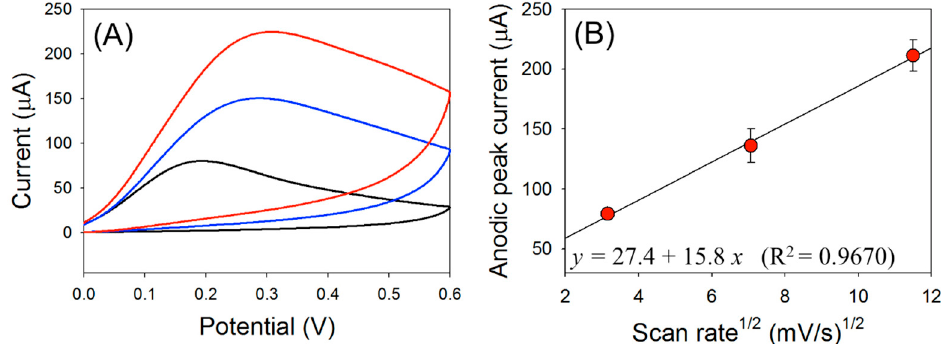
Figure 4. ( A ) Cyclic voltammograms of 10 mM·HZ in Tris buffer with pDA-ITO electrodes at a scan rate of 10 mV/s (black line), 50 mV/s (blue line), and 100 mV/s (red line); ( B ) Dependence of the anodic peak current on the square root of the scan rate.